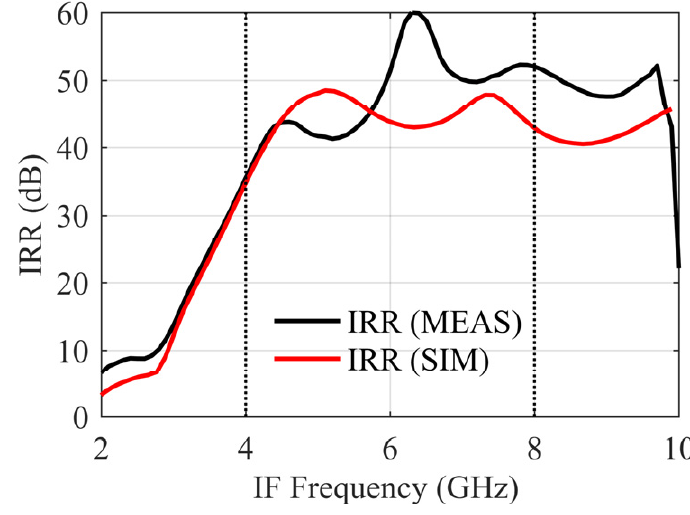
Figure 23. IRR result of receiver MMIC.